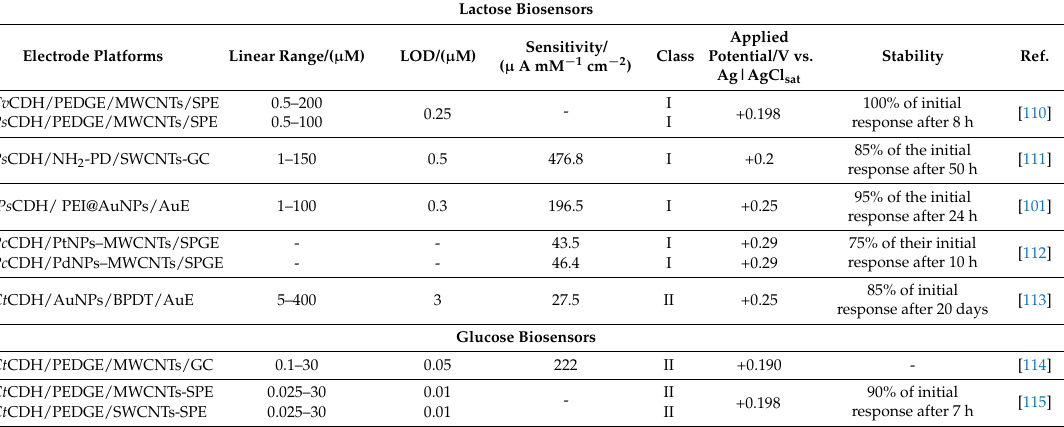
Table 2. Lactose (upper part) and glucose biosensors (bottom part) based on DET of CDH are compared based on several analytical parameters such as linear range, LOD, sensitivity, CDH class, applied potential and stability. Abbreviations: AuE gold electrode, AuNPs gold nanoparticles, Ct